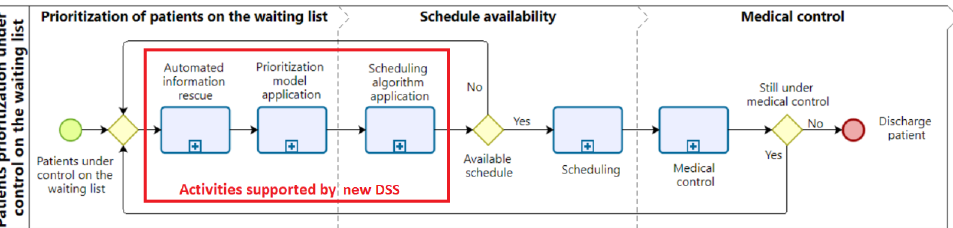
Figure 5. Diagram of the process of prioritizing patients under medical management based on the previous method.